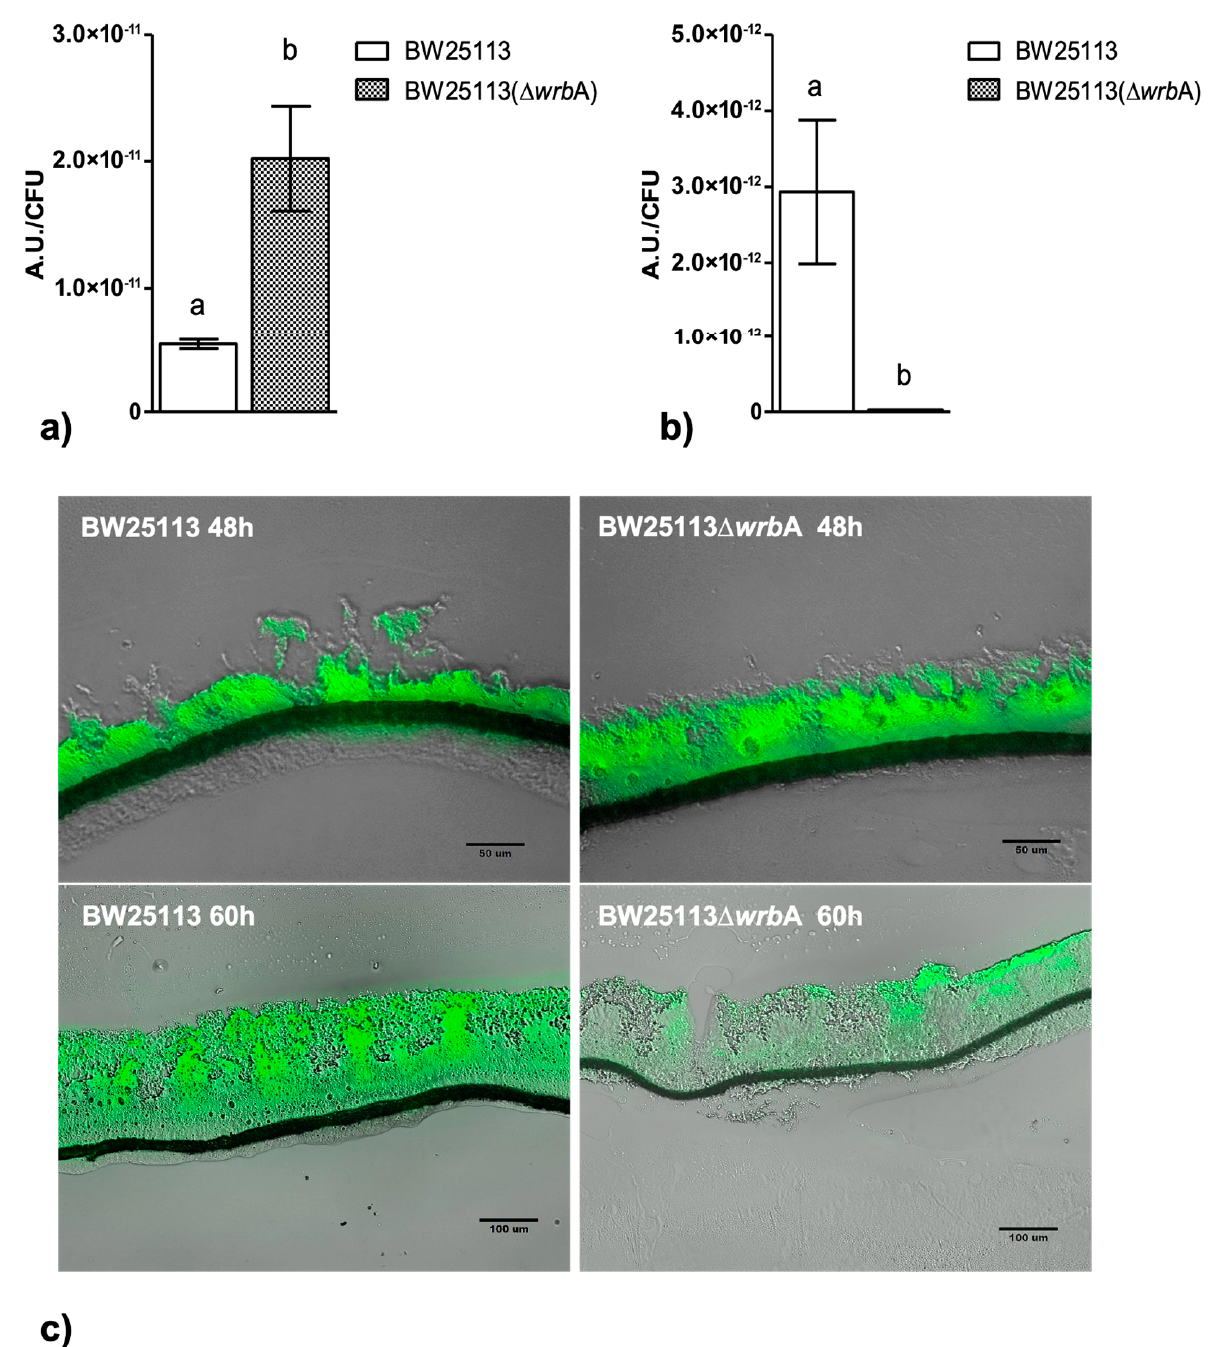
Figure 4. BW25113 and BW25113- ∆ wrb A oxidative stresses within the biofilm at 48 (panel A ) and 60 h (panel B ). Data are shown with the mean of the relative fluorescence (arbitrary unit, A.U.) normalized by the number of biofilm-dwelling cells with the standard deviation. The letters above each column indicate statistically significant differences (Tukey’s HSD, p ≤ 0.05) at the corre-sponding time steps. Panel C shows merged bright field and fluorescence images of cryosections representative of both BW25113 and BW25113- ∆ wrb A biofilms at 48 and 60 h. Samples were stained with the ROS-sensitive probe CellROX green.